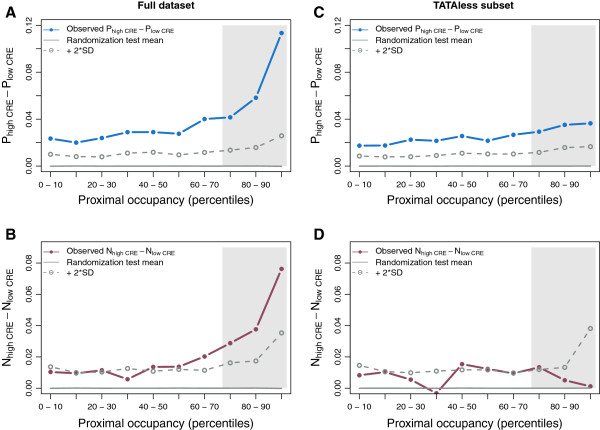
Proximal nucleosomal occupancy, chromatin regulation, and the noise-plasticity coupling. We divided the dataset (n = 2045) in ten equally sized bins of increasing proximal nucleosome occupancy. In each bin, we computed the median chromatin regulation effect (CRE). We plotted the difference in plasticity (A, blue curve) or noise (B, red curve) of genes above/below this median and contrasted the observed values with those expected randomly (permutation test in each bin to depict significance, shown as the mean –gray curve– and mean plus two standard deviations –dashed gray curves– obtained with 10000 randomizations). Plasticity is always enhanced by strong chromatin regulation; however, regulation enhances noise only in promoters with high proximal nucleosome occupancy and TATA box (shaded area in A,B). An identical analysis is shown in (C) and (D), but excluding genes with TATA-containing promoters. High occupancy does not lead to increased plasticity/noise in this case (shaded area in C,D).